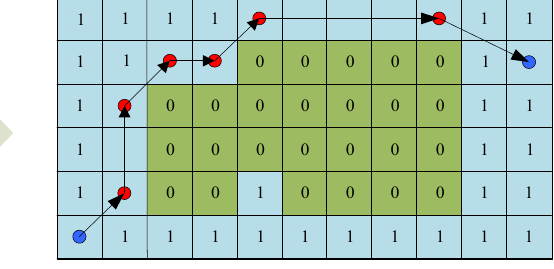
Figure 5. Geographic map and its computational grid for weather routing. The ocean climate and weather information including the wave, wind and current is another essential prerequisite for weather routing, along with geographical information. For better routing, both real-time weather forecast data and historical climate re-analysis data are required for modeling and optimization. In this paper, the most recent and widely used reanalysis dataset ERA5 from the European Center for Medium-range Weather Fore- casts (ECMWF) is used. ERA5 is the fifth generation ECMWF atmospheric reanalysis of the global climate covering the period from January 1950 to the present and could provide an hourly estimation of a large number of atmospheric, land and oceanic climate variables, including 10 m wind speed, 10 m wind direction, mean wave height, mean wave direction and mean wave period. The weather data acquired from ECMWF is coarse and will be interpolated to the computational grid worldwide to compute wind- and wave-added re- sistance and FOC in path planning (Figure 6). As can be seen in Figure 7, the significant wave height and wind distributions on the north Pacific Ocean for three continuous days from 1 November 2020 have obvious differences. Thus, instantaneous real-time path plan- ning and voyage optimization shall be performed day-by-day to predict, assimilate and optimize the route.